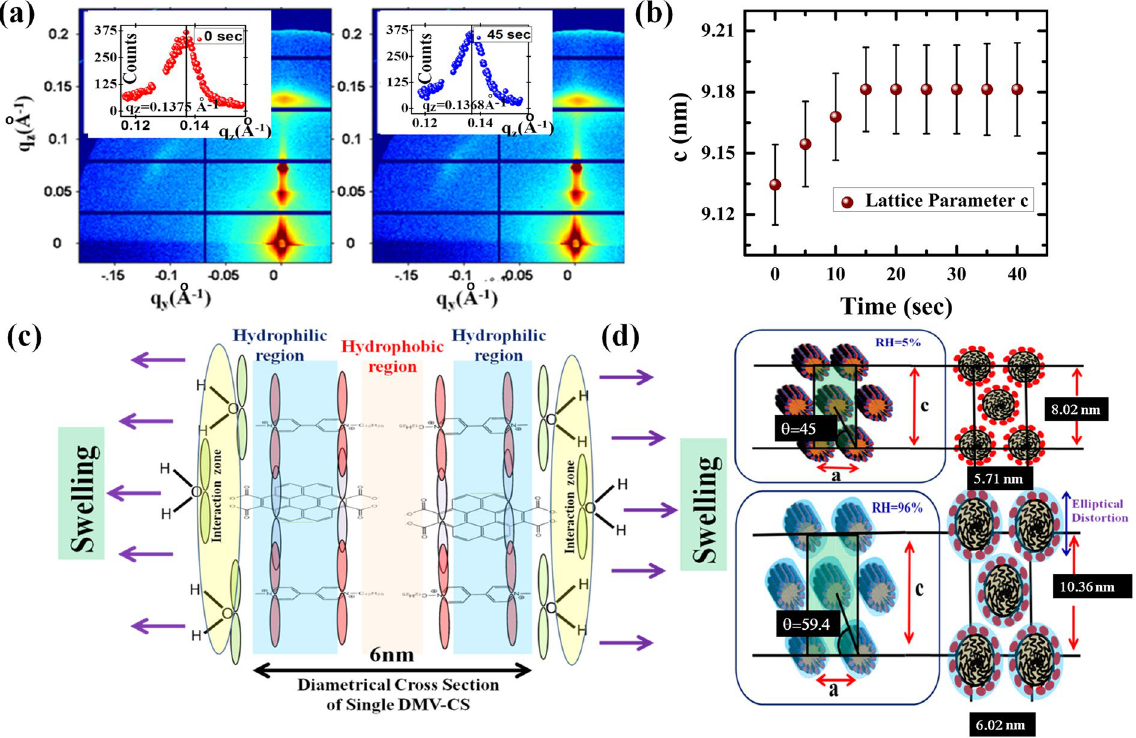
Figure 3. ( a ) GISAXS images of DMV-CS film during transition from RH 52% (left) to RH 75% (right) with insets showing the (0, 0, 2) peak along q z direction. The quick change in the lattice parameter ‘ c ’ with time is shown in the extreme right panel with error bars as the RH value is changed from 52% to 75% - equilibrium state is achieved in about 20 Sec. ( c ) Schematic of the cross section of a nanofiber with two DMV-CS molecules arranged back to back along the diameter of a typical micelle. The hydrophobic zone is in the interior of the micelle with the hydrophobic hydrocarbon chains of DMV molecules facing towards each other. The hydrophilic zone is the upper layer of the cylindrical shell that form DMV-CS charge transfer complex as indicated. ( d ) Internal structure and structural exfoliation of DMV-CS near Hexagonal lattice which was analyzed with a Face Centered lattice with the in plane and out of plane lattice parameters a and c, respectively. The angle between the (0, 0, 2) and (0, − 1, 1) plane reflection θ becomes 60° as this lattice become perfect hexagonal lattice with c = √